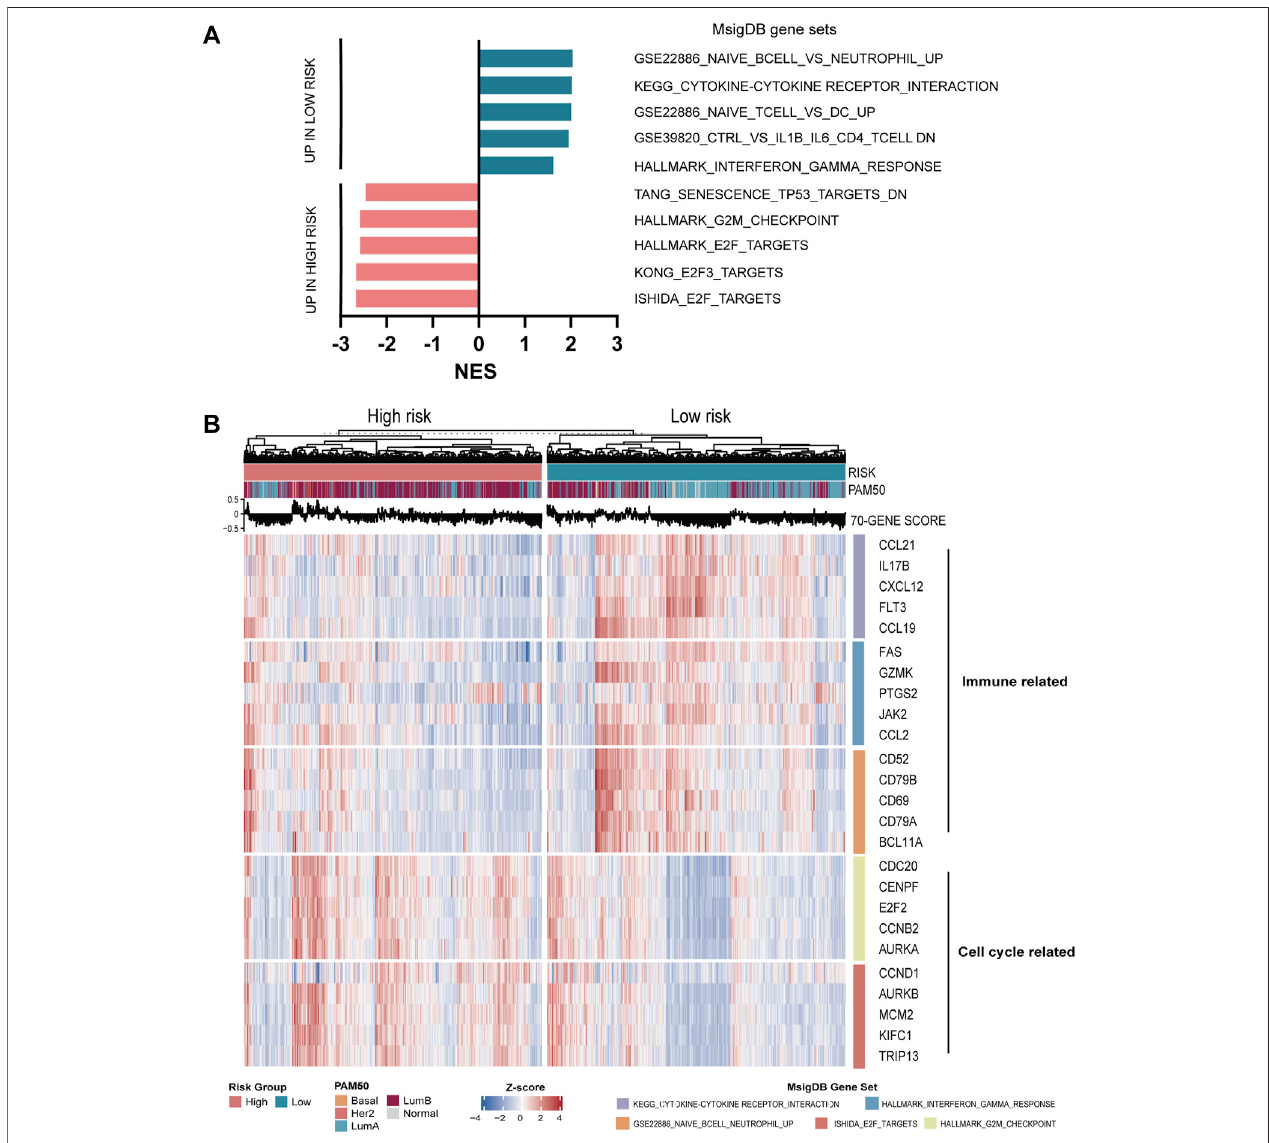
FIGURE 5 | Functional analysis of seven-immune-related-gene IRS. (A) GSEA of IRS. (B) Relationship between seven-immune-related-gene IRS and signaling pathways. IRS: immune risk signature; GSEA: gene set enrichment analysis.